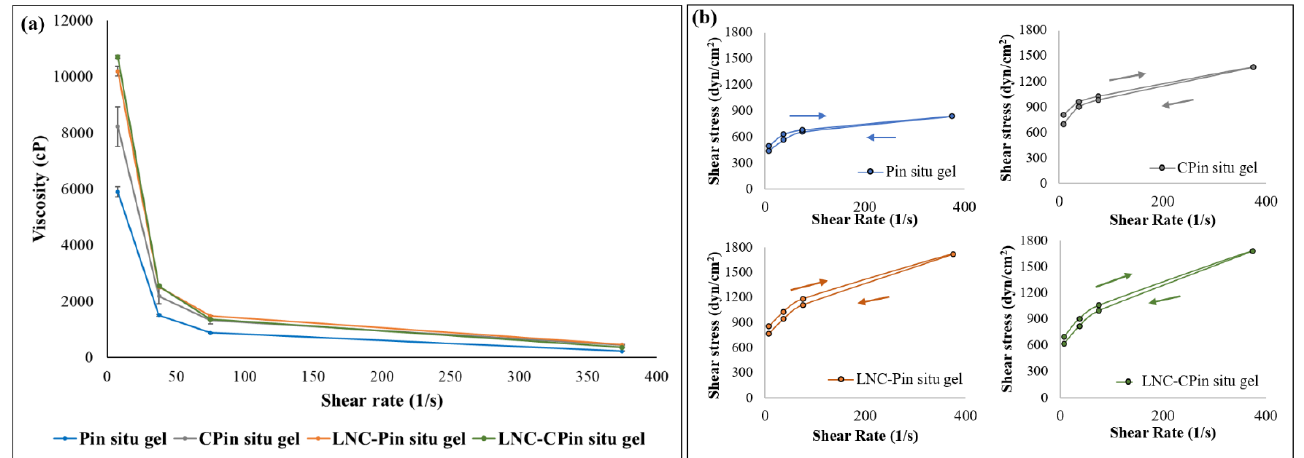
Figure 2. ( a ) Rheogram of blank in situ gels at physiologic temperature. ( b ) Thixotropic behavior of in situ gels.